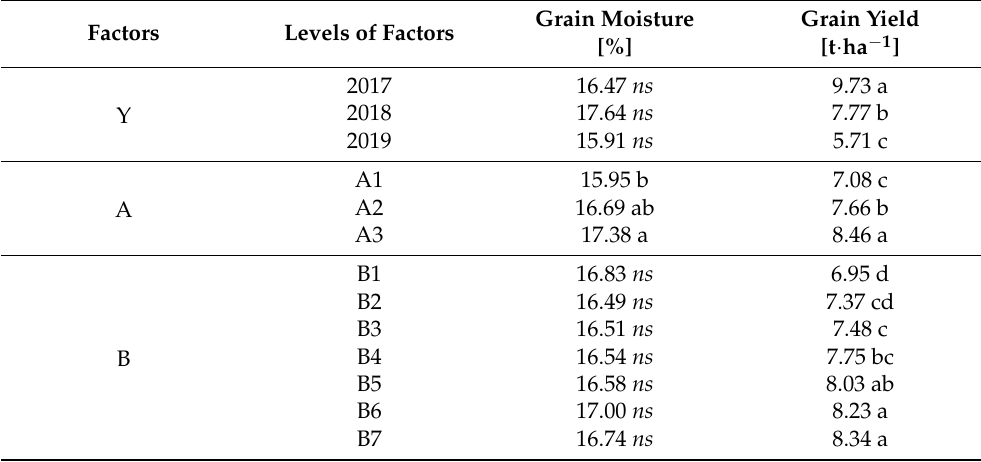
Values in columns marked with at least one same letter are not significantly different; ns —not